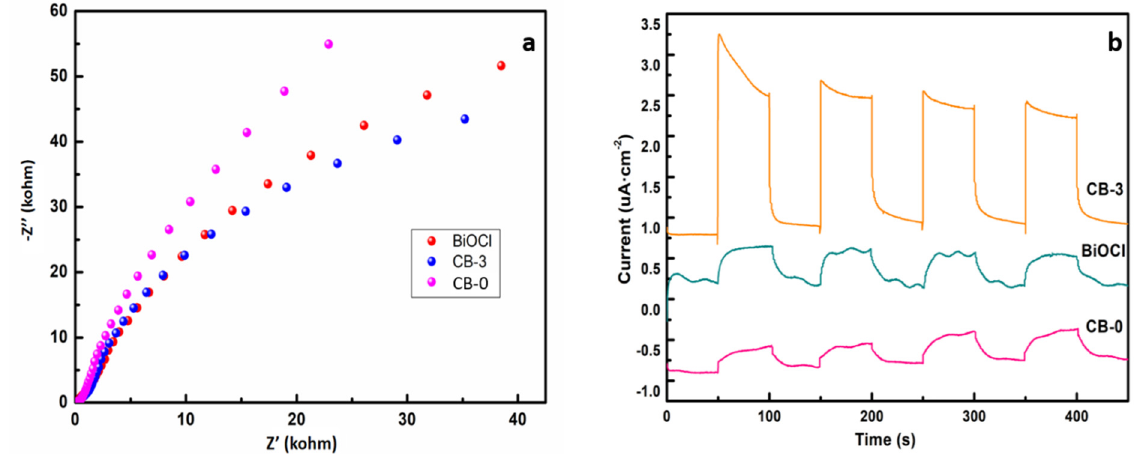
Figure 9. ( a ) Transient photocurrent responses, ( b ) electrochemical impedance spectroscopy.